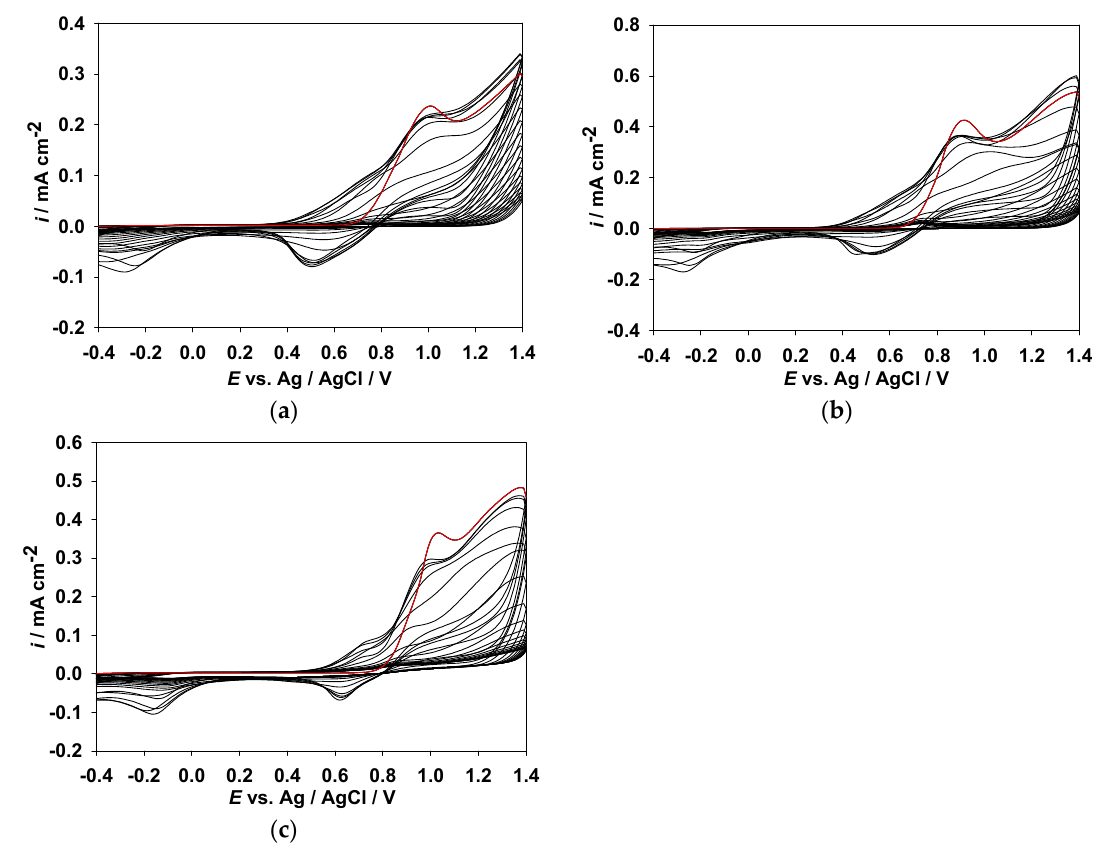
Figure 2. Cyclic voltammograms of 2 mM ( a ) MPS; ( b ) MPO, and ( c ) ANIL in 0.1 M LiClO 4 /EtOH/EA at a scan rate of 100 mV·s − 1 on an ITO working electrode. The red line indicates the first cycle of CVs.